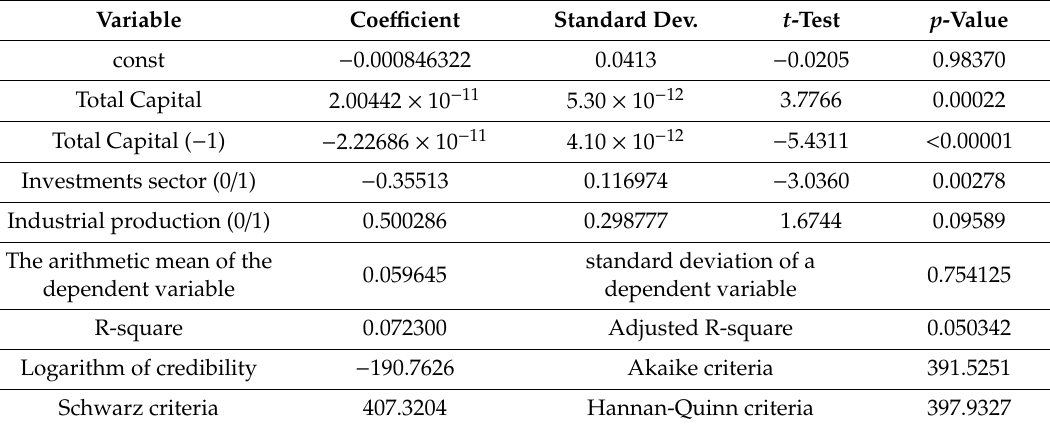
Table 8. Model of the determinants of marketability discount in